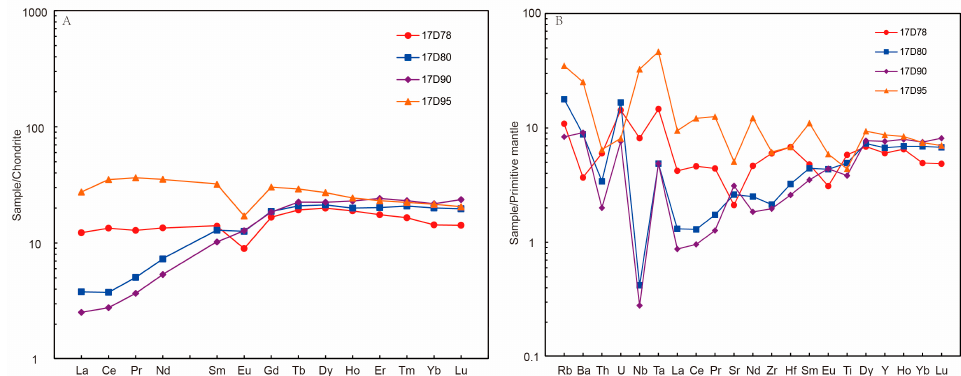
Figure 9. Chondrite-normalized REE patterns ( A ) and primitive mantle-normalized spidergrams ( B ) for garnet clinopyroxenites. The chondrite and primitive mantle values are from Sun and McDonough [64].